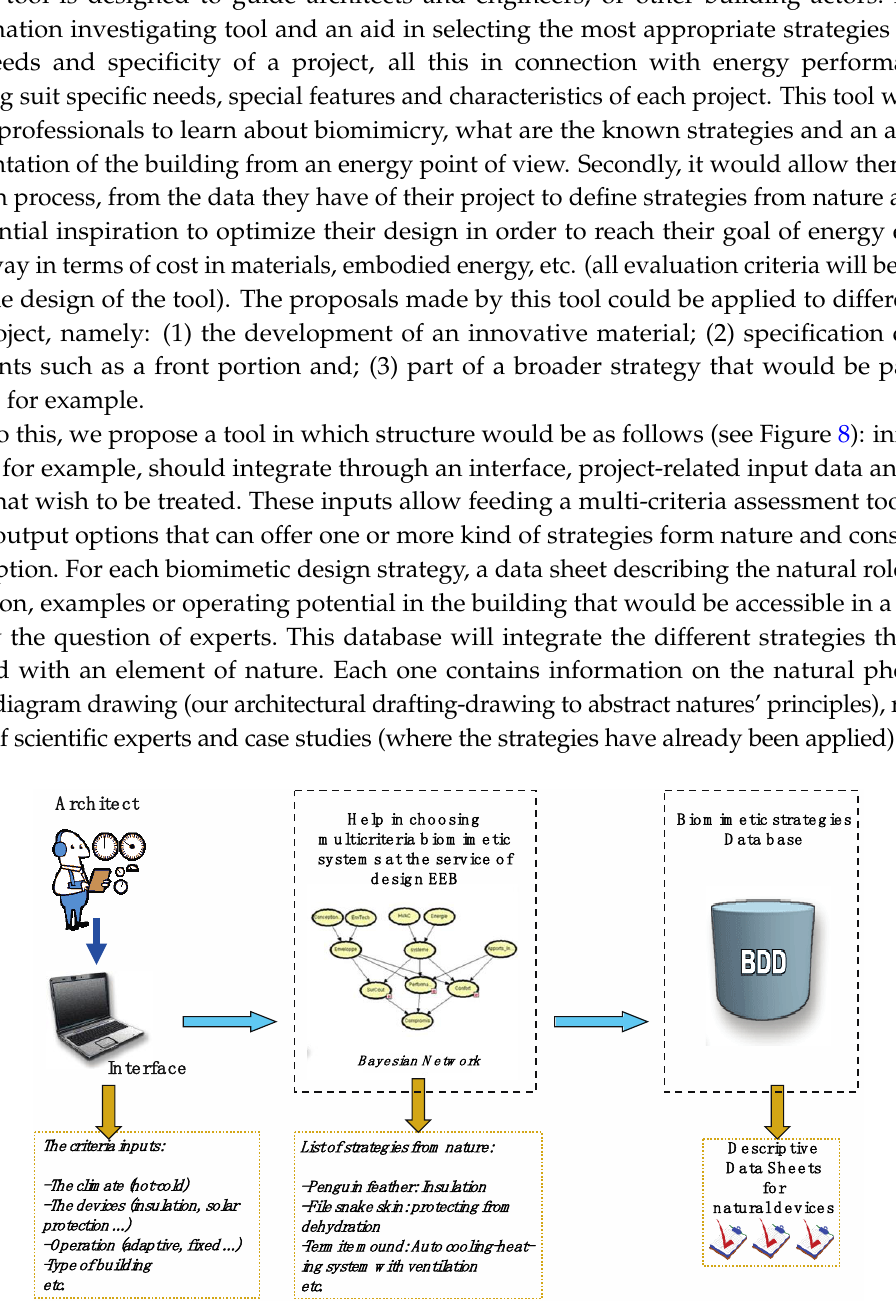
Figure 7. An example of a small network within a data analysis platform (computing) searches and formalizes the relationship knowledge between biology and architecture.